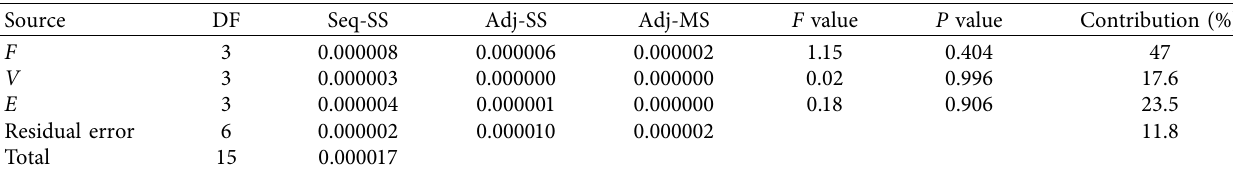
Table 7: ANOVA result for machining